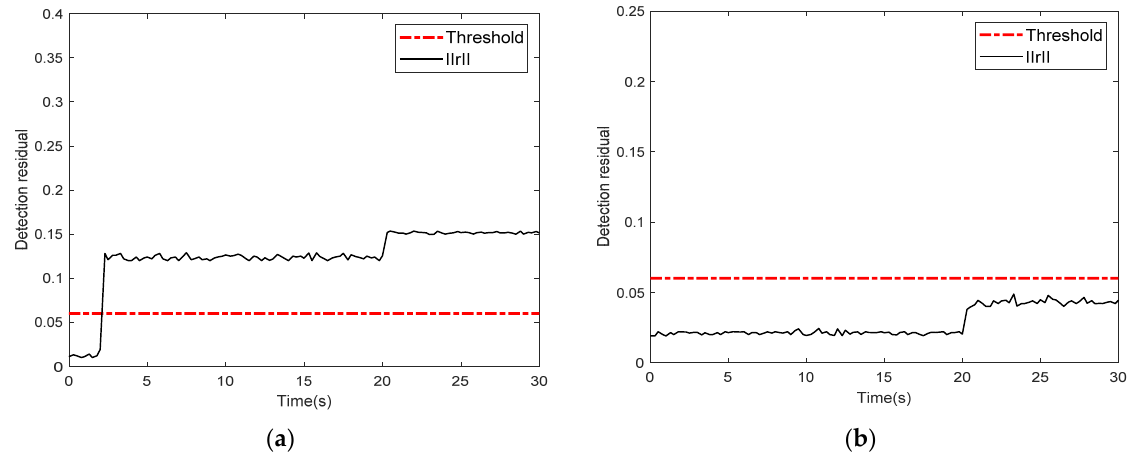
Figure 2. Fault detection results. ( a ) Detection results in the case of failure. ( b ) Detection results without failure.